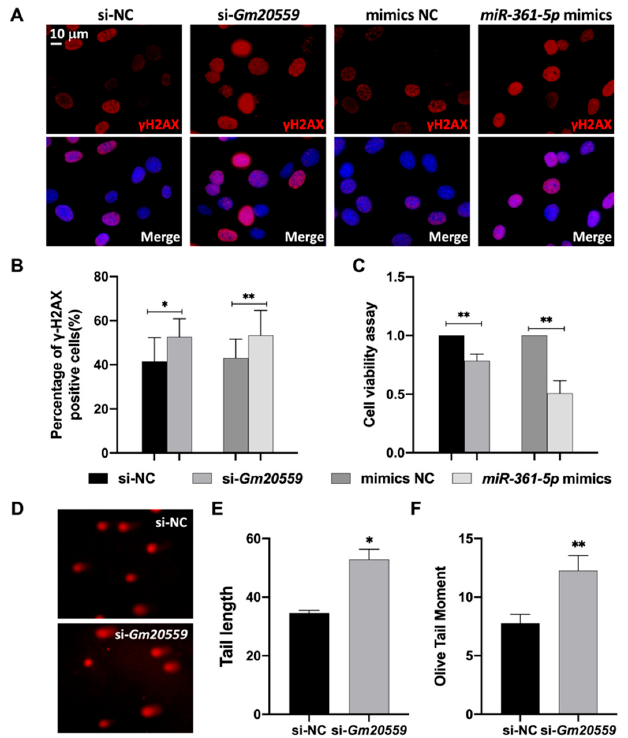
Figure 5. Gm20559 knockdown or miR-361-5p mimics enhanced DNA damage and decreased cell viability in 661W cells. 661W cells were transfected with si-NC, si- Gm20559 , NC mimics, or miR-361- 5p mimics and exposed to UV irradiation. ( A ) The cells were then double-stained with γ -H2AX (red) and DAPI (blue). Scale bars: 10 μ m. ( B ) The percentage of γ -H2AX-positive 661W cells was increased in si- Gm20559 cells compared with si-NC and was increased in cells treated with miR-361-5p mimics compared with NC mimics. ( C ) CCK8 assay showed that the cell viability of 661W cells was markedly impaired by Gm20559 knockdown or miR-361-5p mimics. ( D ) The alkaline comet assay was used to detect the level of DNA damage in 661W cells. The tail length ( E ) and the olive tail moment ( F ) were significantly upregulated in Gm20559 knockdown cells. Data are presented as the mean ± SD from 3 independent experiments. * p < 0.05, ** p < 0.01.